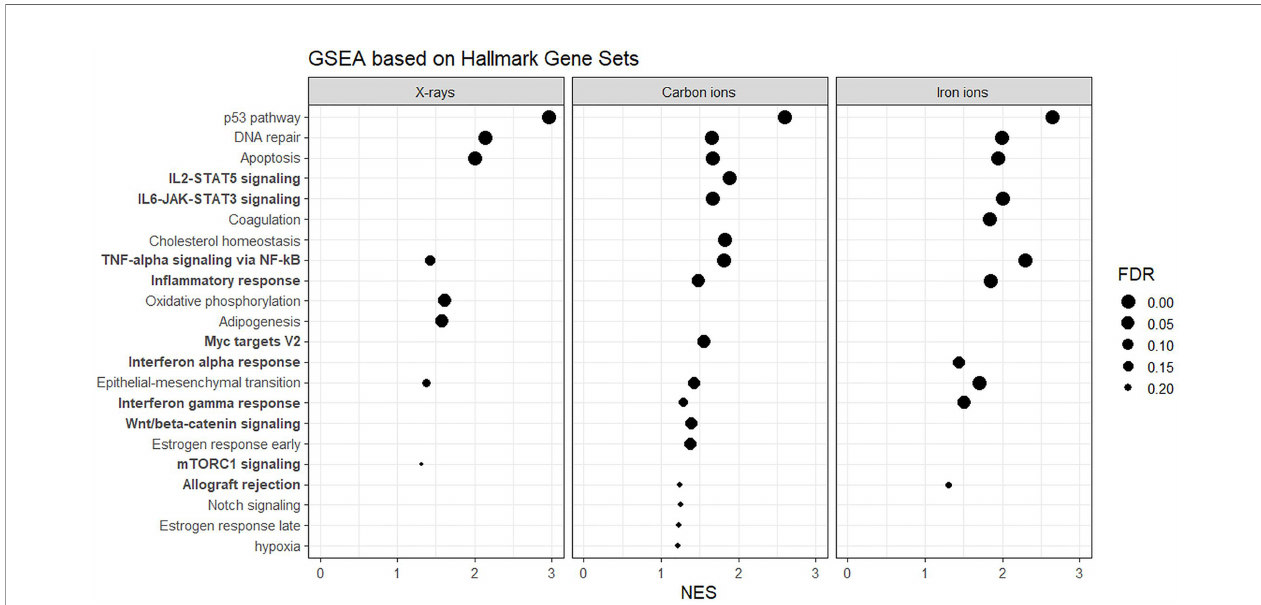
FIGURE 4 | GSEA based on Hallmark Gene Sets. Gene sets related to the immune system and in fl ammation are in bold. NES, normalized enrichment score; FDR, false discovery rate